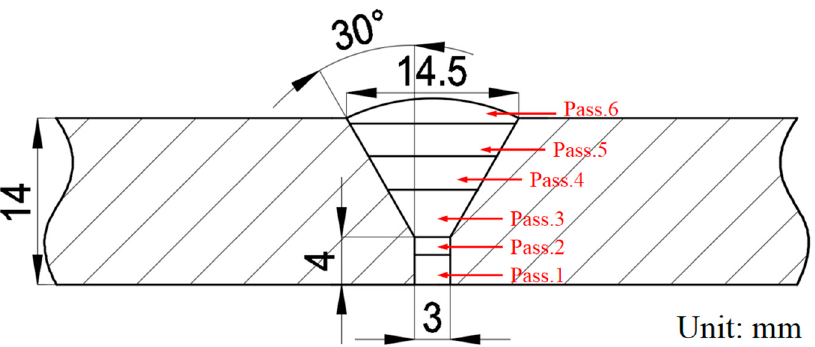
Table 2. Technological parameters of the welding process.